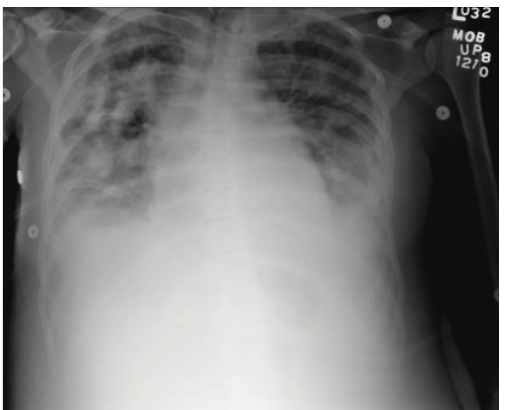
Figure 5: Chest X-ray showing progression of diffuse pulmonary